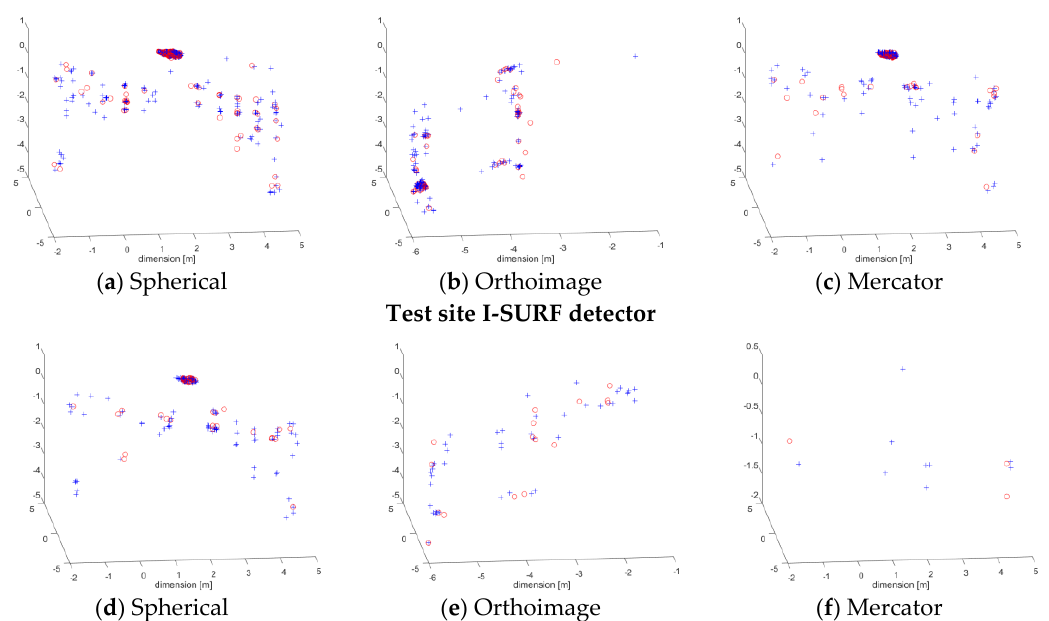
Figure A.2. Distribution of points used in the TLS data orientation process for the pair of scans for the scanner stations for test sites I : “The Queen’s Bedroom” -the worst distribution of the control (blue) and check points (red). Points detected by FAST ( a – c ) and SURF ( d – f ) detectors on raster images: ( a/d ) in the spherical projections, ( b/e ) in the orthoimage and ( c/f ) in the Mercator projection.